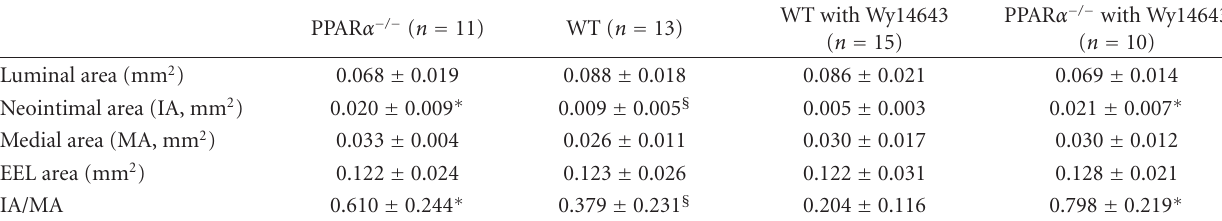
Table 1: Morphometric data at 21